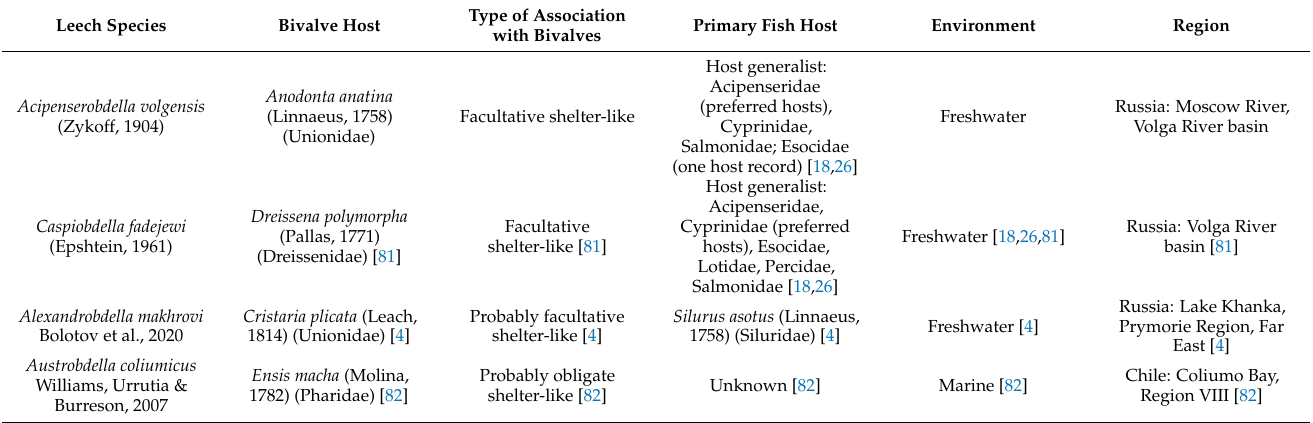
Table 2. Global checklist of bivalve-associated fish leeches (Hirudinea: Piscicolidae) that are known to occur in the mantle cavity of mussels and clams in freshwater and marine